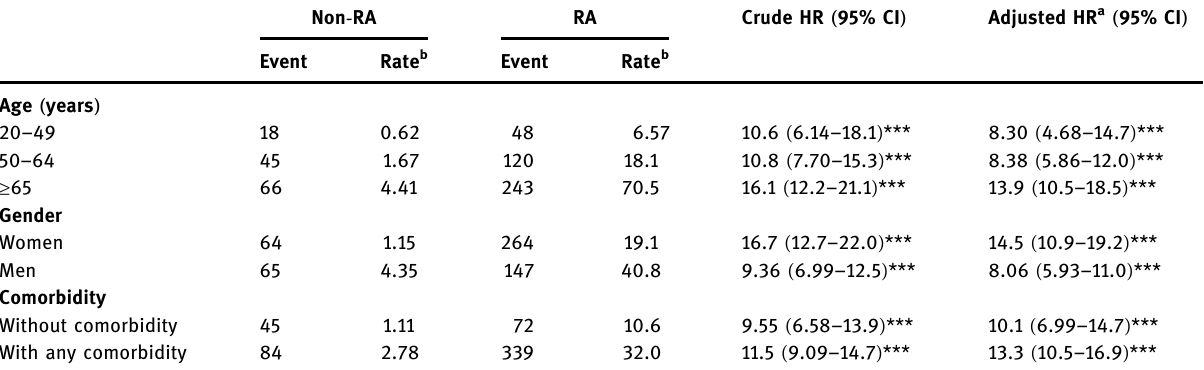
Table 3: Incidences and hazard ratios of empyema for patients with RA compared to those without RA Non - RA